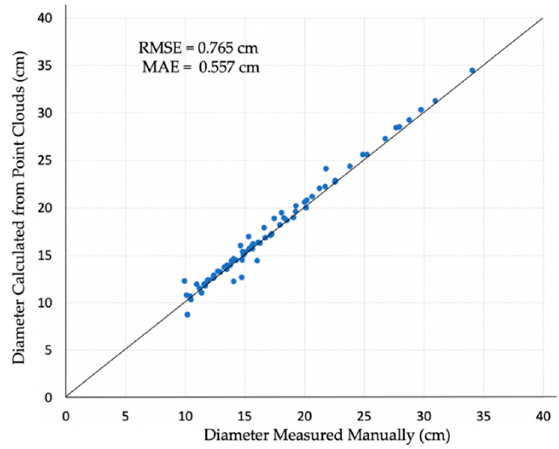
Figure 17. Comparison of manually-measured and calculated diameters.